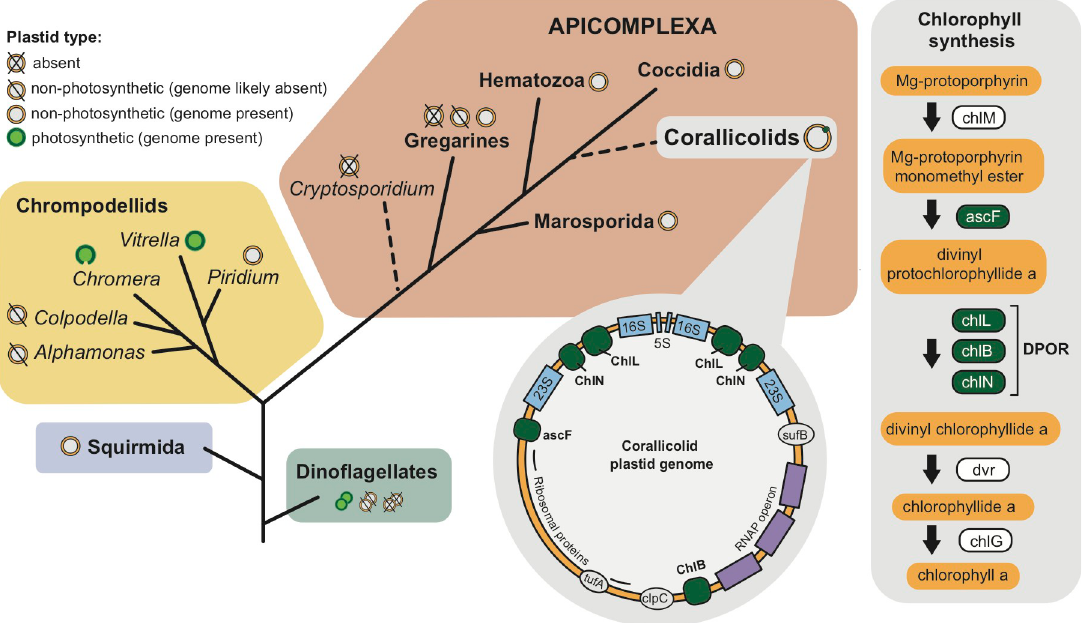
Fig 2. Phylogeny of the Apicomplexa and their close relatives depicting the putative phylogenetic position of the corallicolids and their unique plastid. A summary of the distribution of plastids, photosynthesis, and plastid genomes is plotted on the tree (the Chromera plastid genome is shown linear, and the dinoflagellate plastid genomes are fragmented into many small chromosomes). The presence of 4 genes involved in chlorophyll synthesis ( acsF , chlL , chlN , and chlB ) on the corallicolid plastid genome are shown in dark green on a simplified plastid map. The putative function of these enzymes in the chlorophyll synthesis pathway is presented. All other enzymes in this pathway ( chlM , chlG , and dvr ) are ancestrally plastid-targeted proteins that are encoded by nuclear genes (so their presence in corallicolids remains to be tested as genomic data are not yet available). DPOR AU : AnabbreviationlisthasbeencompiledforthoseusedinFig 2 : Pleaseverifythatallentriesarecorrect : , dark-operative protochlorophyllide reductase; RNAP, RNA polymerase.